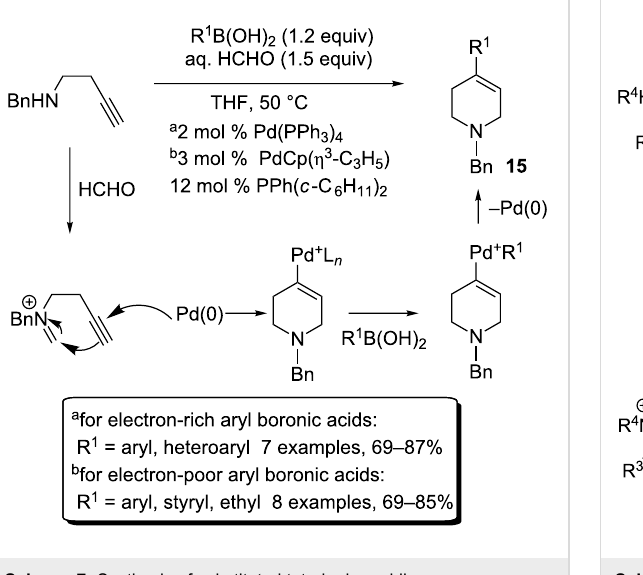
Scheme 7: Synthesis of substituted tetrahydropyridines. Scheme 8: Synthesis of more substituted